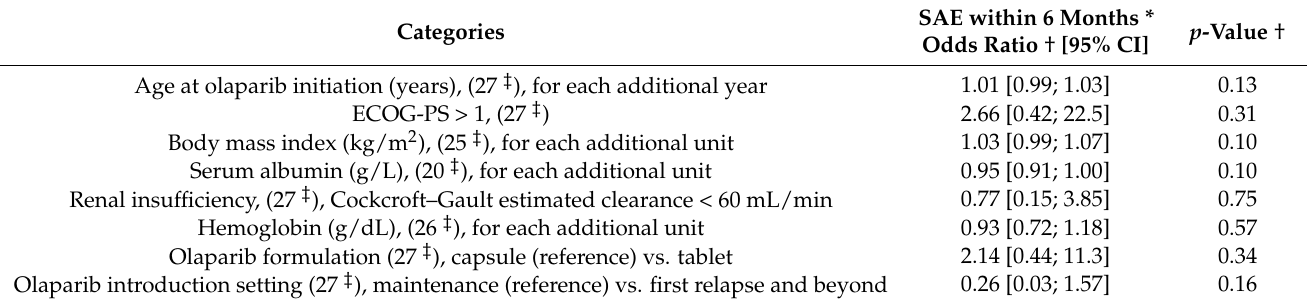
Table 2. Association between baseline patient characteristics and risk of olaparib toxicity. Categories